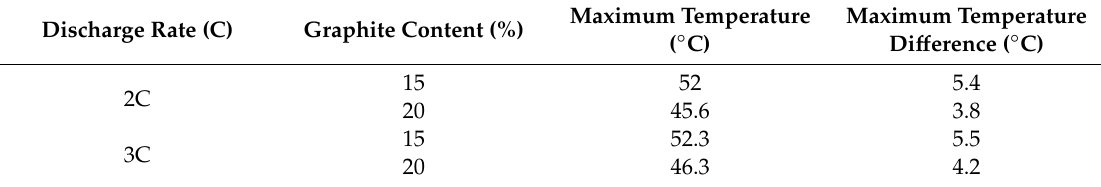
Table 6. Maximum temperature and maximum temperature di ff erence of the battery surface when the battery is heat dissipated using di ff erent graphite content PCM, combined with thermoelectric cooling sheets under di ff erent discharge